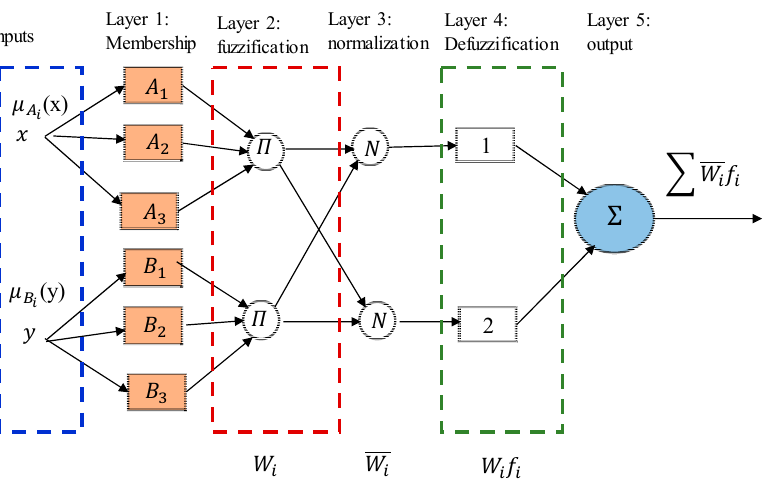
Figure 4. Architecture of ANFIS model.